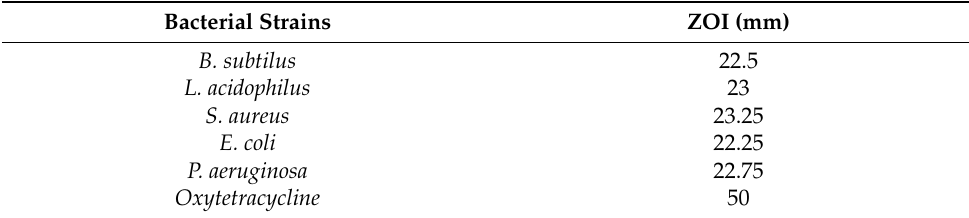
Figure 11. The zone of inhibition with different dilution (D1–D4) (1000-125 μ g/mL ) of various bacterial strains. ( A ) B. subtilus , ( B ) L. acidophilus , ( C ) S. aureus , ( D ) E. coli , ( E ) P. aeruginosa , ( F ) control (Oxytetracycline) against Ag 2 ONPs with different concentrations. 3.7.4. Antifungal Assay